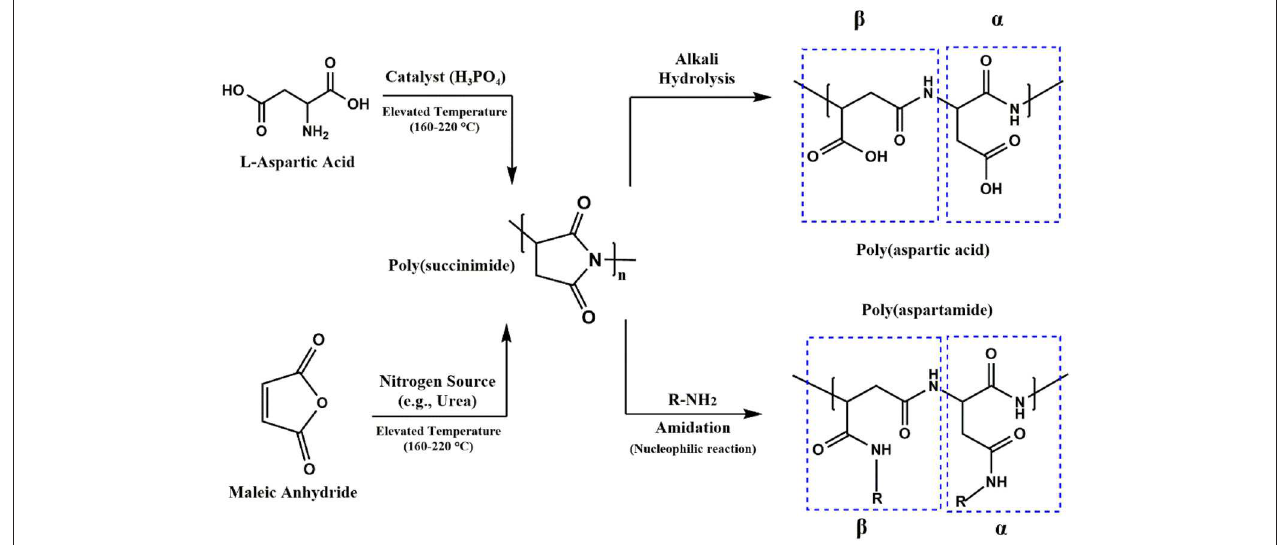
FIGURE 1 | Synthesis procedure of PSI, PASP, and poly(aspartamide). PSI can either be obtained through poly-condensation (usually at elevated temperature > 160 ◦ C using an acid as the catalyst) of ASP or malic acid (synthesized by maleic anhydride and a nitrogen source such as urea or ammonia). PSI can be hydrolysed under alkali media to yield PASP or reacted with primary amines (without catalyst at room temperature) to yield poly(aspartamide) derivatives. The ring opening of succinimde groups occurs both at α and β sites in amidation and hydrolysis